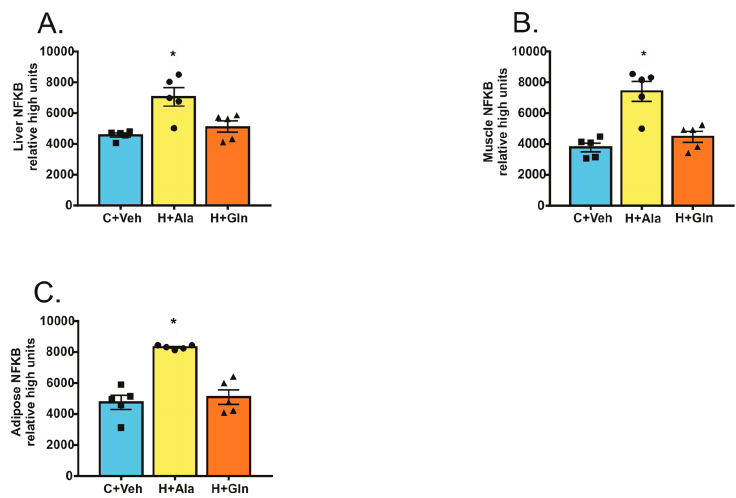
Figure 5. Nuclear factor kappa B (NF- κ B) in the liver ( A ), muscle ( B ), and adipose tissue ( C ). Rats that received the chow diet and vehicle (C+Veh, n = 5), rats fed with a high-fat diet and supplemented with Alanina (H+Ala; n = 5), and rats fed with a high-fat diet and supplemented with glutamine (H+Gln, n = 5). Values were displayed as mean ± SEM. One-Way-ANOVA with the Bonferroni post-test was used. * p < 0.05 vs. C+Veh and H+Gln.